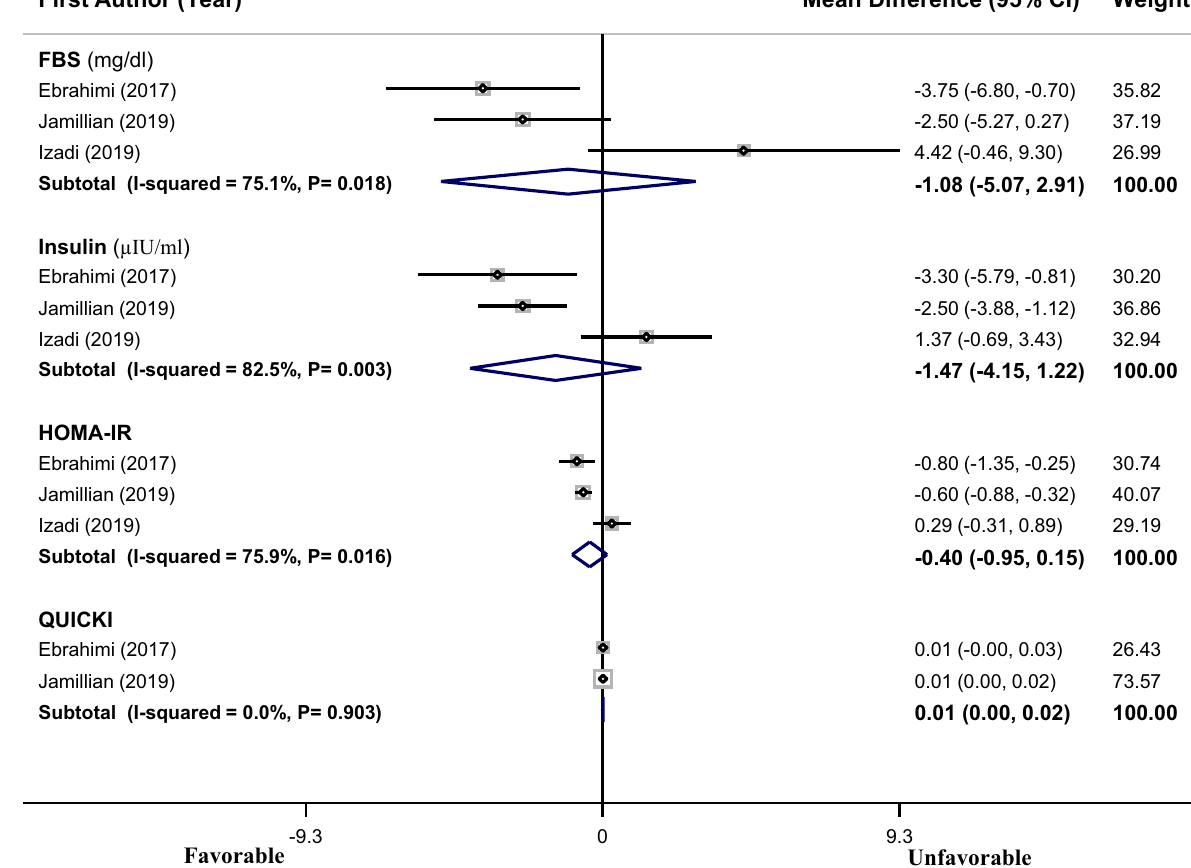
Figure 4. Forest plots of the effect of vitamin E supplementation or vitamin E along with omega-3 or magnesium supplementation on glycemic indexes. If the diamond does not touch the vertical line (or the line of null effect), the overall effect is statistically significant. No significant effects of vitamin E supplementation or vitamin E supplementation plus omega-3 or magnesium on glycemic indices were found in PCOS